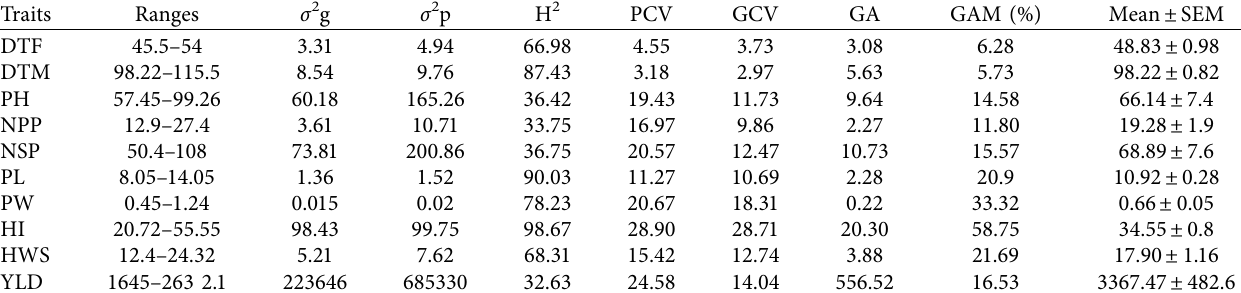
Table 3: Mean, minimum, and maximum values were recorded for ten quantitative variables in 100 common bean accessions from Ethiopia